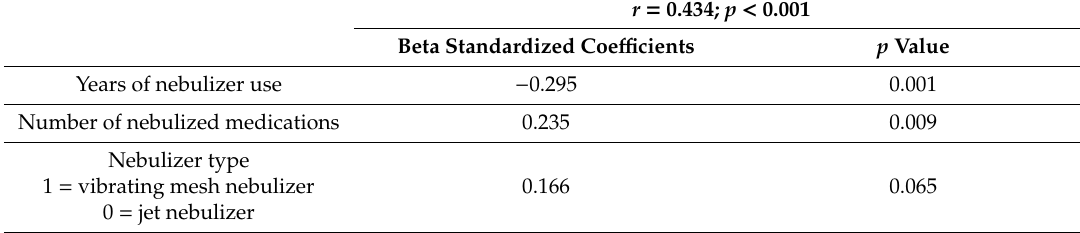
Table 3. Associations of nebulizer disinfection / maintenance score with years of use, number of nebulized medications, and type of